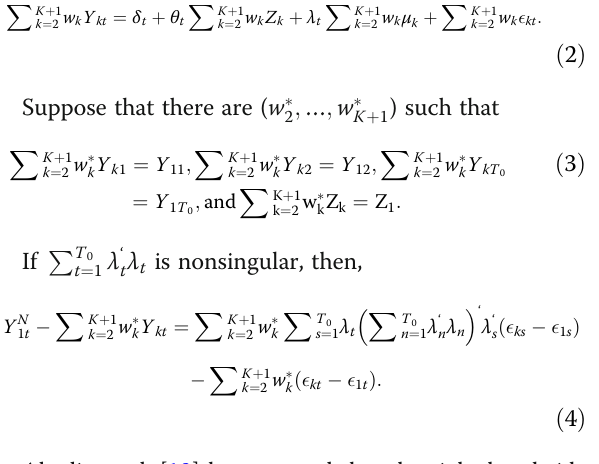
particular value of W represents a potential synthetic control, which is a weighted average of all cities in the control group. The outcome variable for each synthetic control indexed by W